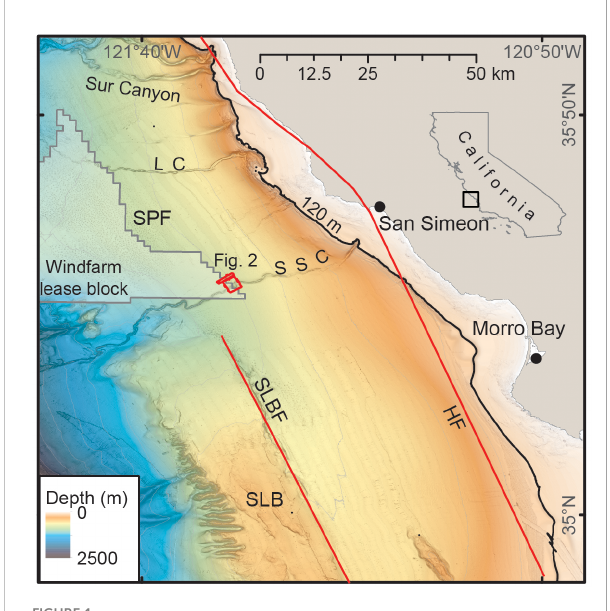
FIGURE 1 Regional map of the Morro Bay continental slope. SSC, San Simeon Channel; LC, Lucia Chica Channel; SPF, Sur Pockmark Field; SLB, Santa Lucia Bank; SLBF, Santa Lucia Bank Fault; HF, Hosgri Fault. Red lines are approximate locations of labeled faults. High- resolution survey and paired sub-bottom pro fi les of the San Simeon Channel bend highlighted in red outline (Figure 2). Gridded gray polygon outlines the proposed leasing block for offshore windfarm development.